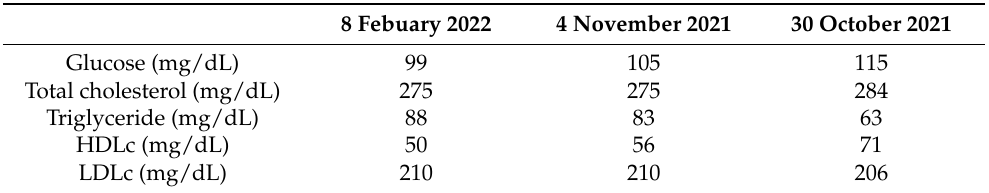
Table 1. Patient’s metabolic markers on a carnivore diet. Glucose (70 to 99 mg/dL), total cholesterol (desirable <200 mg/dL, borderline high 200–239 mg/dL, high >239 mg/dL), triglycerides (optimal: <100 mg/dL), HDL (low male: <40 mg/dL), low density lipoprotein (LDL) (Optimal: <100